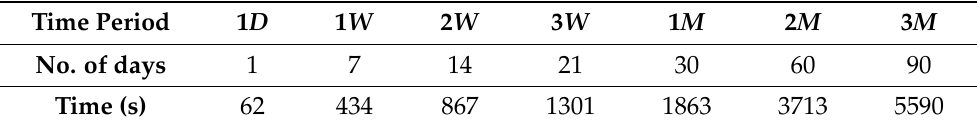
Table 22. Real time elapsed for calculating the constants in seven different simulation time ranges ( D ay, W eek, and M onth).